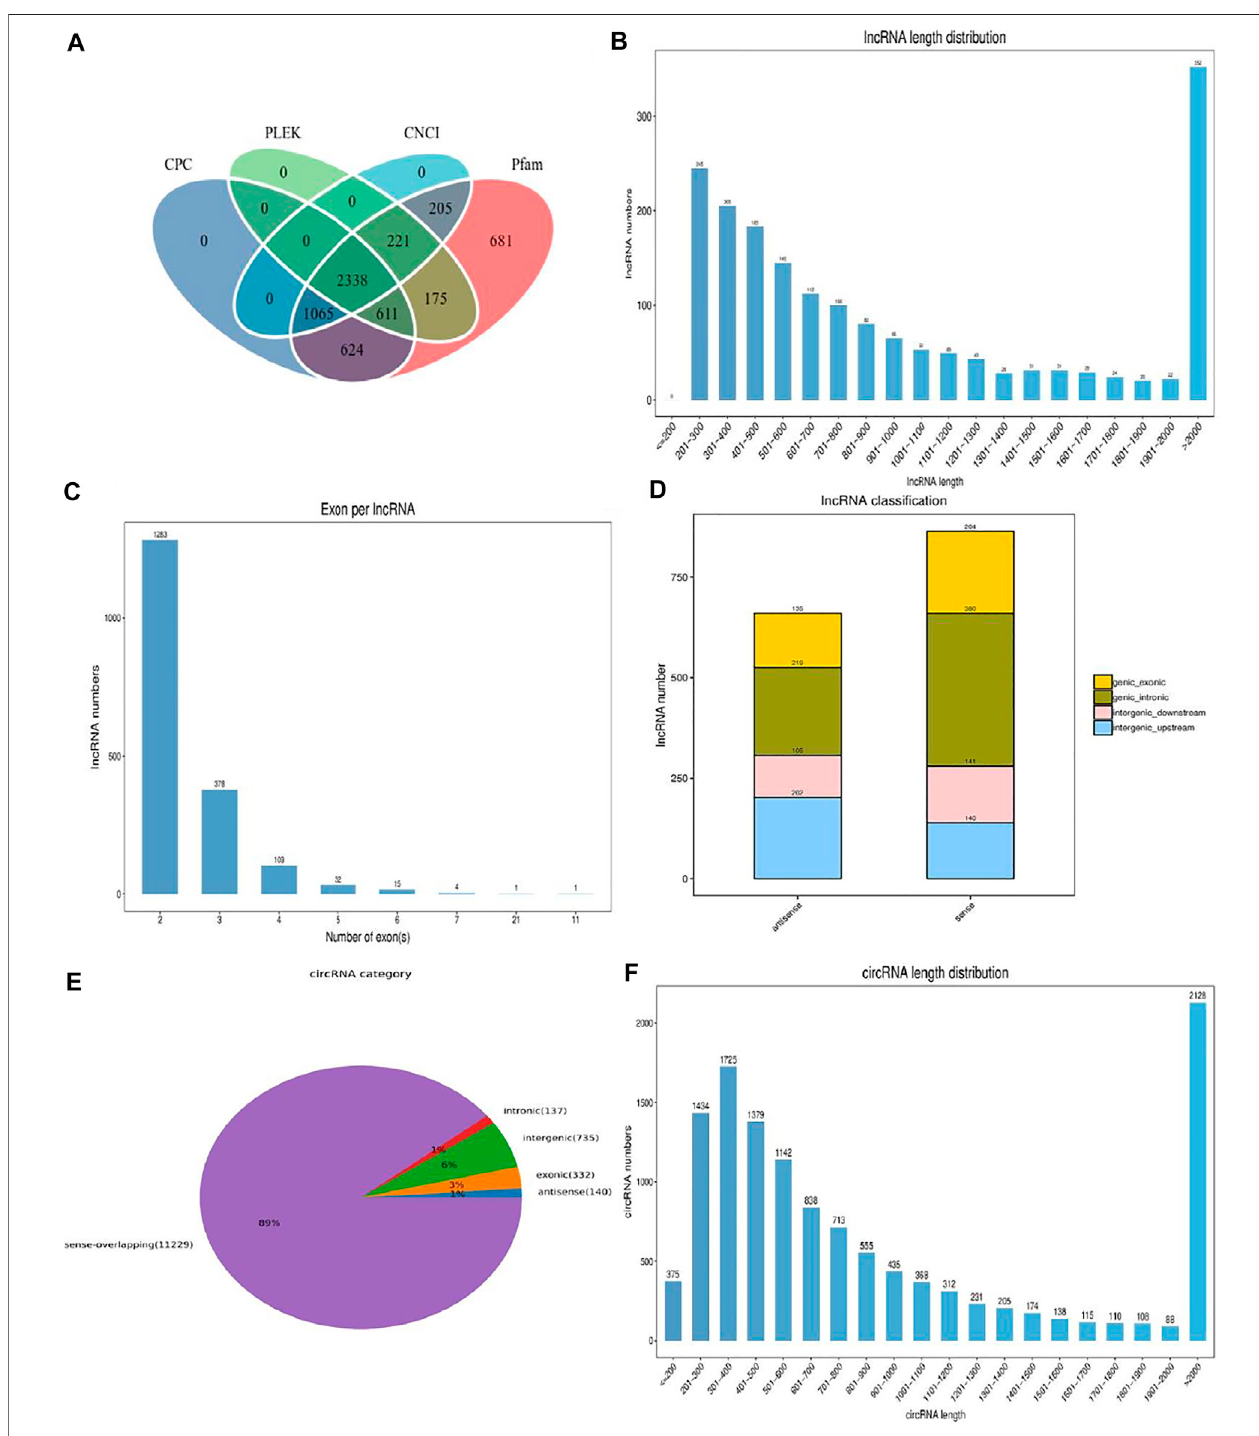
FIGURE1| Thedescription ofidenti fi edlncRNAs andcircRNAs. (A) ScreeningofthecandidatelncRNAs in longissimusdorsi muscle. (B) Thelengthdistribution of the novel lncRNAs. (C) Exon number distribution of novel lncRNAs. (D) The classi fi cation of novel lncRNAs. (E) The structure type pie chart of circRNAs. (F) The length distribution of